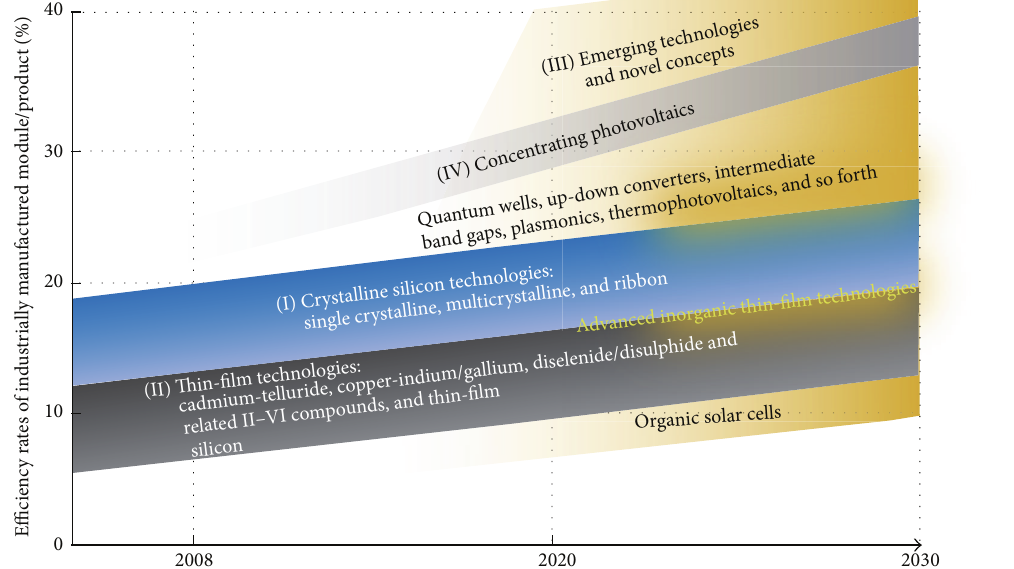
Figure 2: Developing PV technology status and prospects [10].